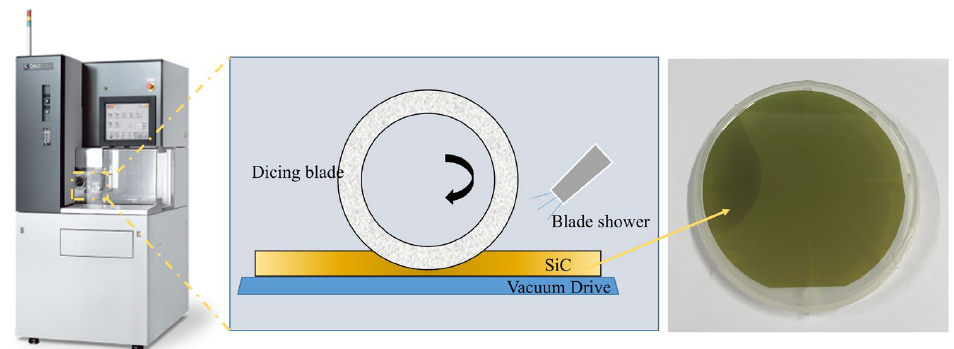
Figure 3. Experimental machine and material.